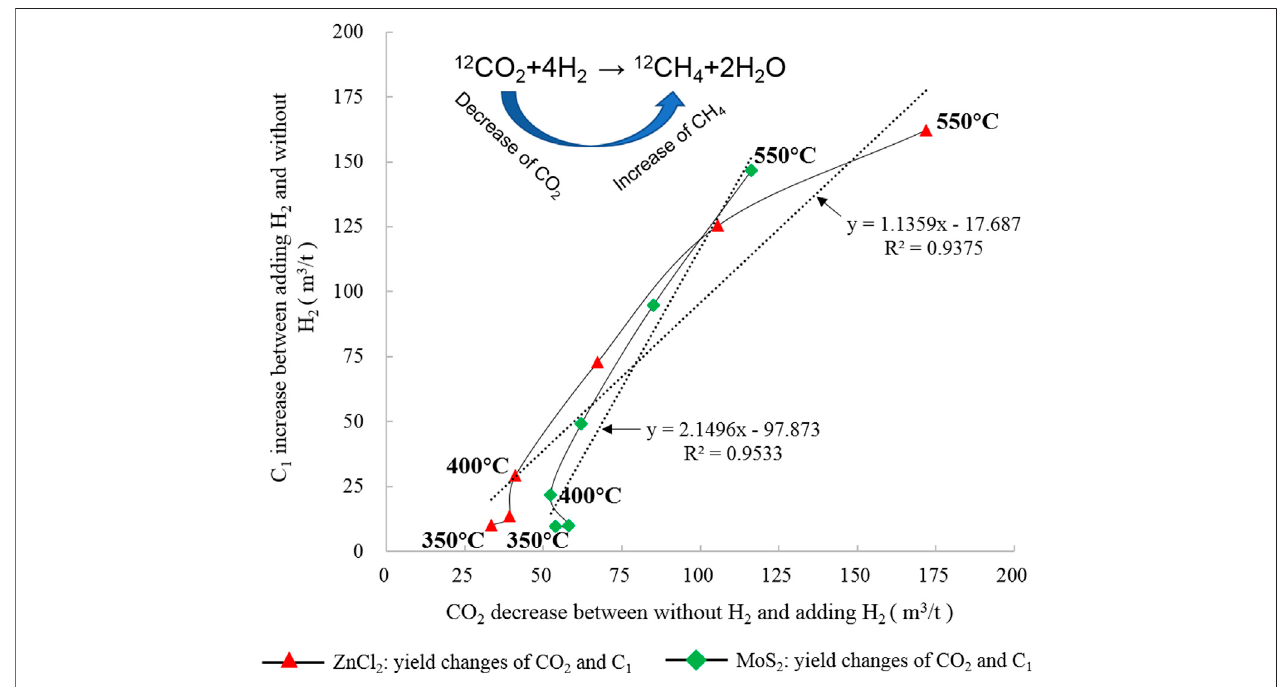
FIGURE 13 | Changes in the characteristics of C 1 and CO 2 under different catalytic hydrogenation control conditions simulated of the closed system.